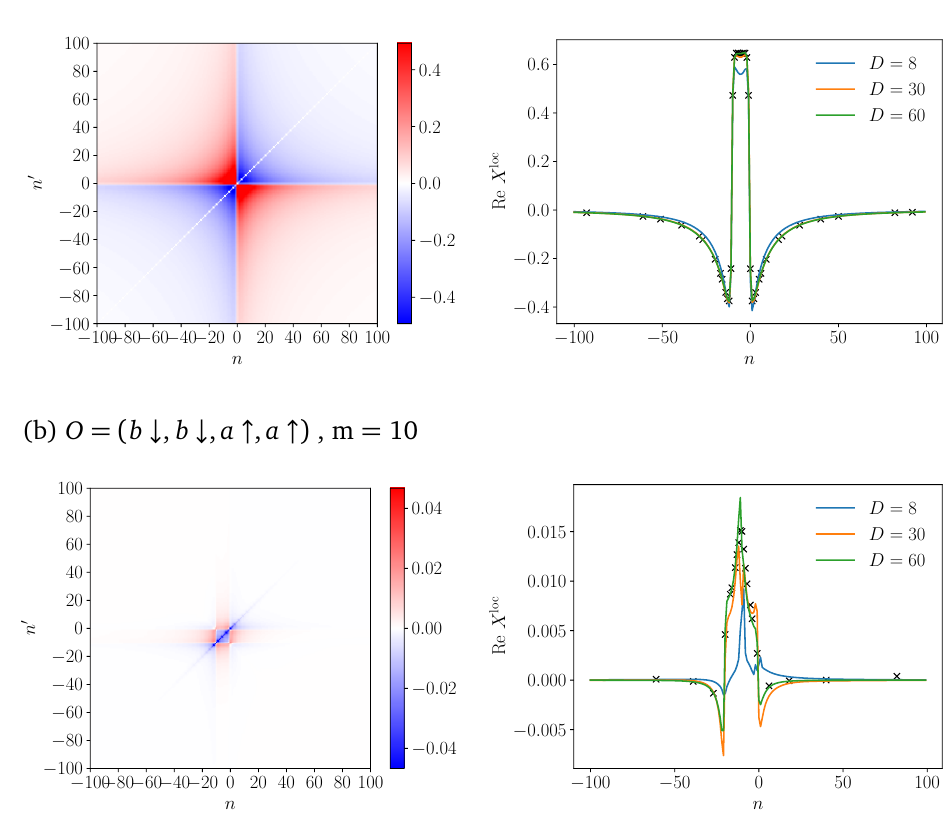
Figure 8: Local 2P Green’s function G loc interpolated at zero bosonic frequency m = 0 [ (a) ] and a finite bosonic frequency m = 10 [ (b) ] for the two-band Hubbard model. The 2D color maps show results of the local 2P Green’s function for D = 60. The right-hand halves of the panels (a) and (b) show the convergence of the interpolated values with respect to D on the line of n (cid:48) = n +